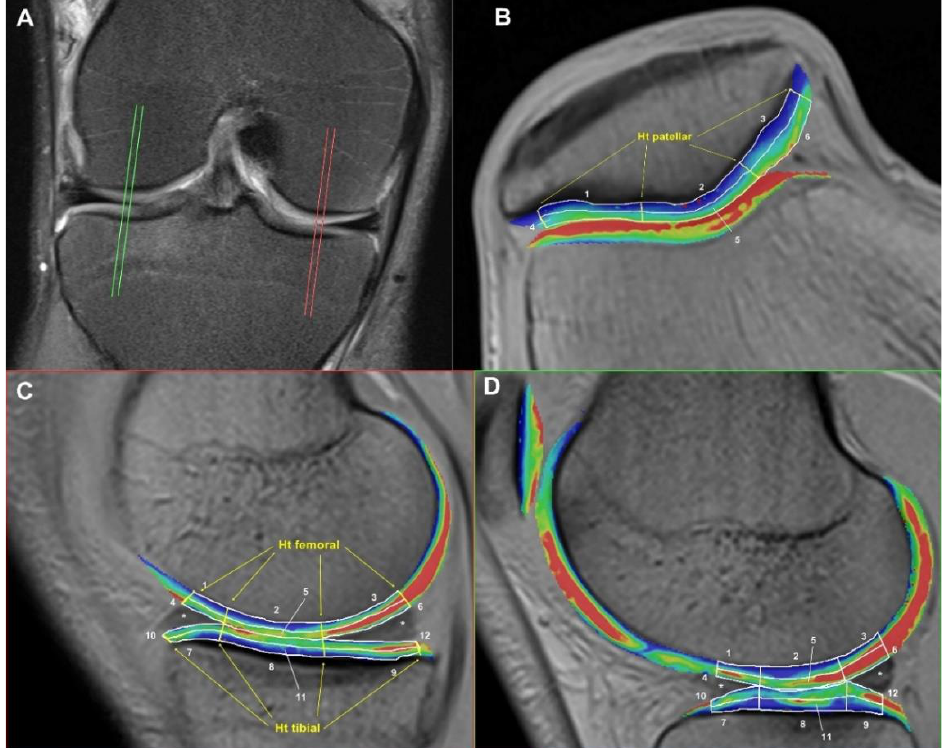
Figure 1. MR Image Postprocessing for the Quantification of Cartilage Ht and T2* (the numbered cartilage ROIs match to those, as explained in Table 2). ( A ): Four sagittal slices (two central layers each in the lateral and medial FTJ); ( B ): fused colored T2* maps (syngo™ -MapIt fusion technique) of axial FLASH T2*w GRE in the FPJ with ROIs for patellar T2* and Ht measurement between the medial, central, and lateral zones; ( C , D ): fused colored T2* maps of sagittal FLASH T2*w GRE in the medial FTJ ( C ) and lateral FTJ ( D ) with ROIs for T2* and Ht measurement between the anterior, central, and posterior zones of the femoral and tibial cartilage segments. The coloring relatively reflects the intensity of the water signal or the water concentration, respectively, reaching from blue to green, yellow, and red. Blue: weak signal / low water content, red: strong signal / high water content. Table 2. Outline of ROIs for cartilage segments, layers, and zones in the FTJ and retropatellar. FTJ: ROIs Zones Layers Segments Slices in FTJ